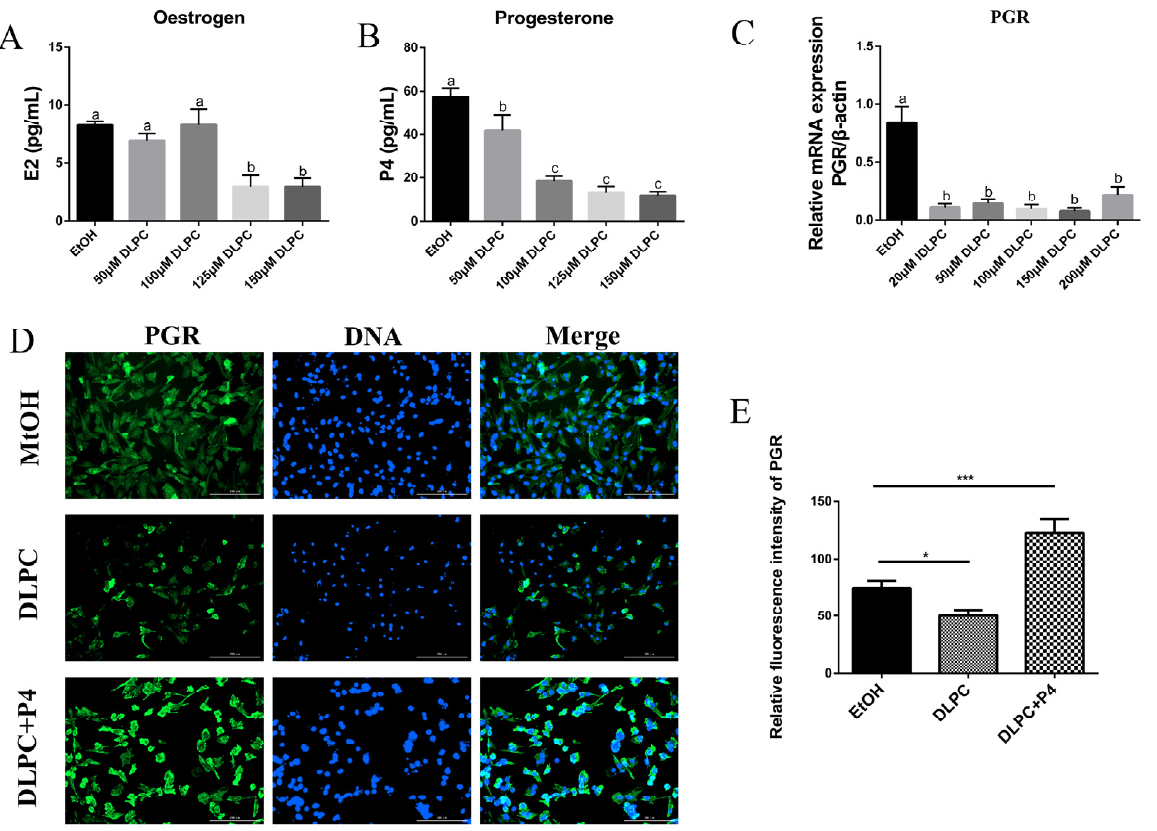
Figure 3. DLPC blocked progestogen receptor signaling pathway. ( A ) The effect of DLPC on 17 beta- estradiol (E2) production of granulosa cells. The concentration of oestradiol was detected by ELISA assay. ( B ) The effect of DLPC on progestogen (P4) production of granulosa cells. ( C ) The mRNA levels of progestogen receptor in granulosa cells by treatment with DLPC. ( D ) Immunofluorescence of progestogen receptor in granulosa cells by treatment with 50 μ M DLPC or/and 10 μ M P4. ( E ) Quantification of progestogen receptor was analyzed with Image J software. Bar: 200 μ m. Data are expressed as the mean ± SEM from three independent replicates. Values with different letters (a, b, c) indicate significant differences in bars ( p < 0.05). * p < 0.05, *** p < 0.001, comparing the indicated groups.